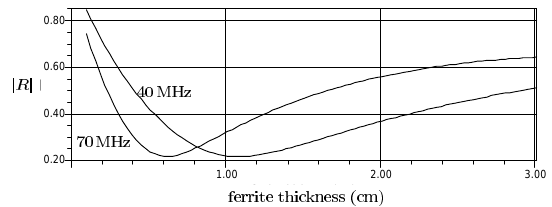
FIG. 14. Reflection coefficient of ferrite vs thickness for two incident